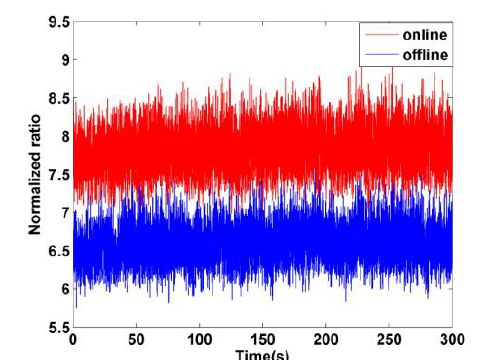
Figure 6 On-line and off-line normalized echo